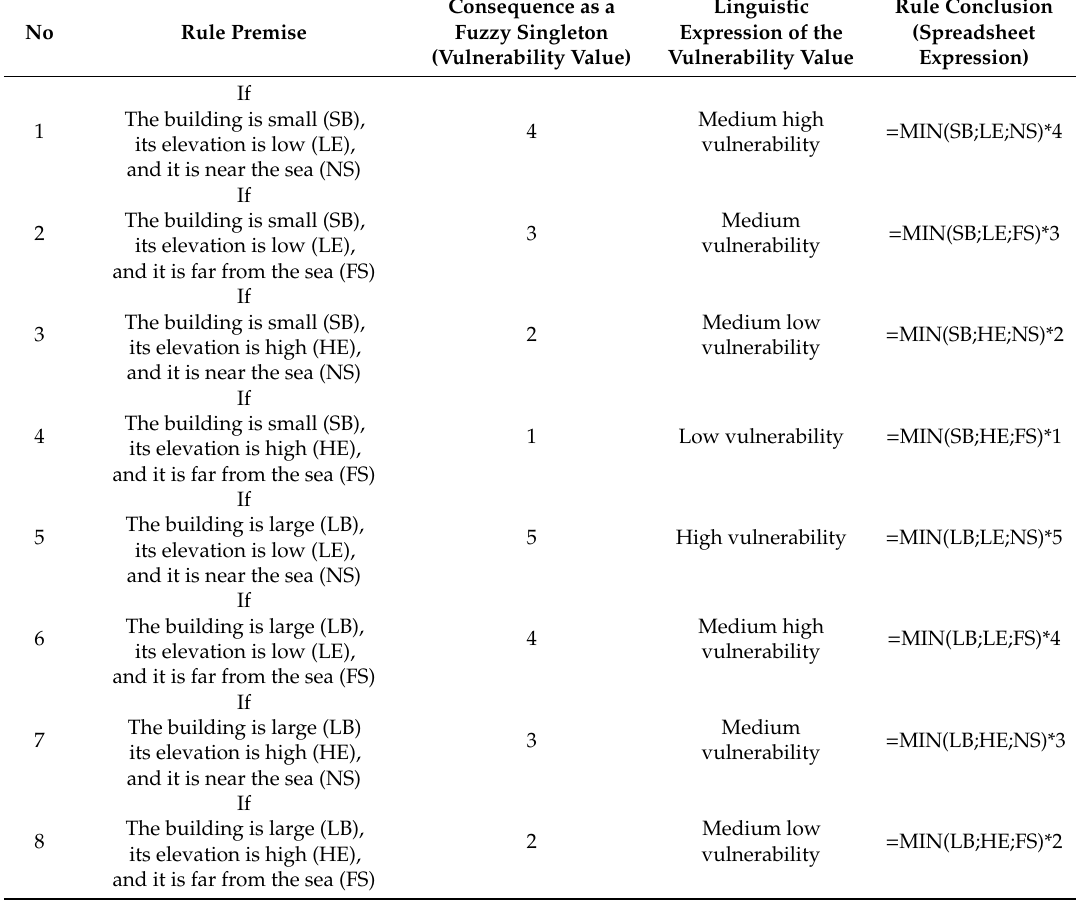
Table 4. Rules with their linguistic expressions and spreadsheet expressions for the calculation of the rule conclusions.